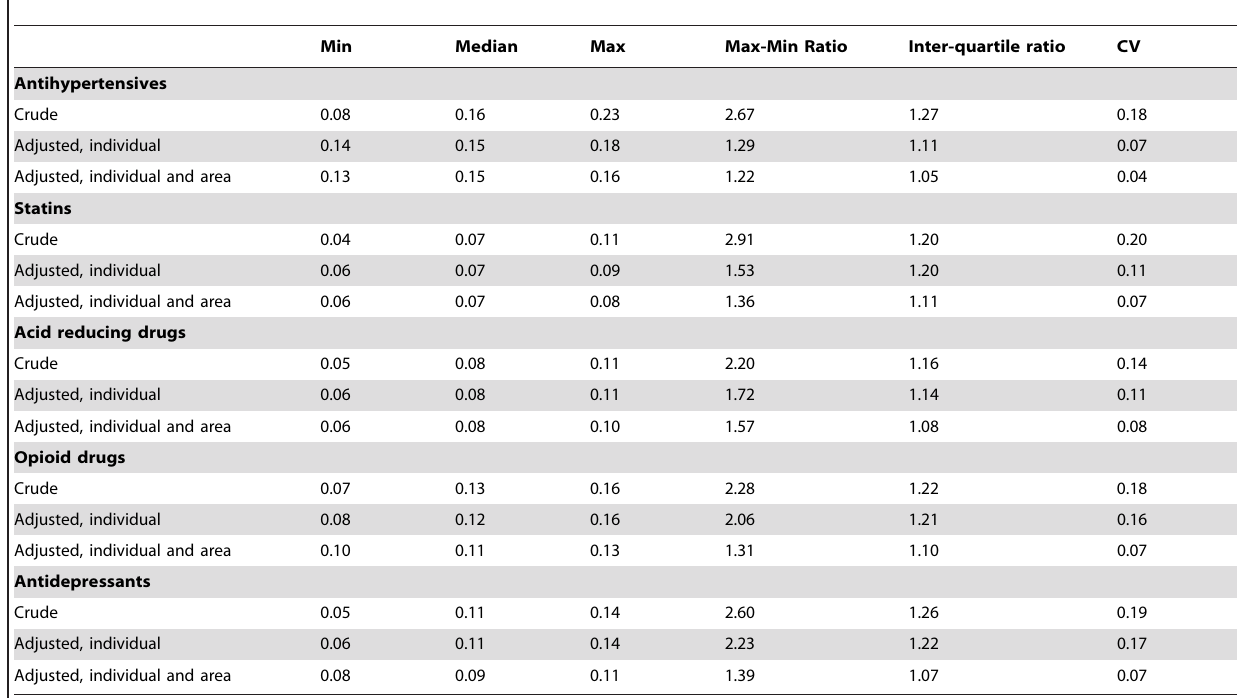
Table 3. Summary statistics for regional variations in rates of purchasing one or more prescription from specific therapeutic categories in 2006, non-rural local health areas of British